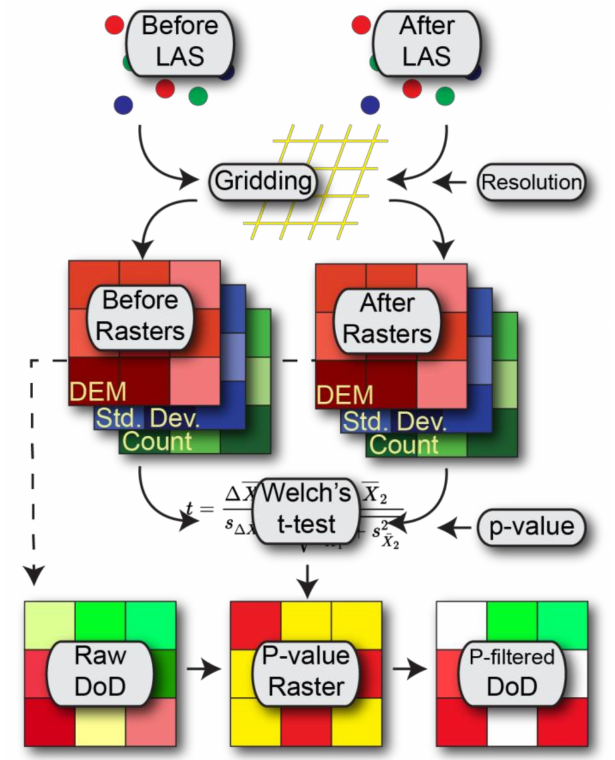
Figure 1. Flowchart showing an overview of the Las2DoD